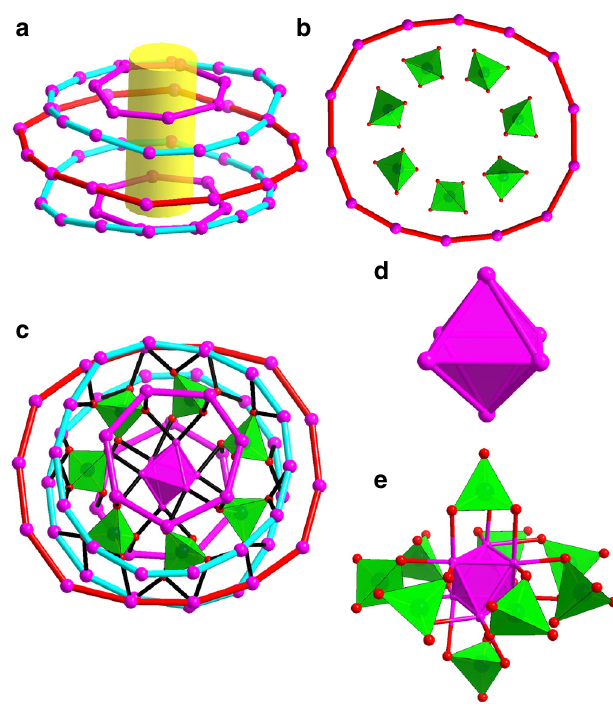
Fig. 3 Disassembled skeletal structure of SD/Ag7 . a Five concentric metallocycles: two Ag 7 (purple); two small Ag 14 (cyan) and one large Ag 14 (red). b Seven MoO 4 2 − anions arranged along the equatorial Ag 14 ring. c The bonding of MoO 4 2 − with Ag 14 rings and inner Ag 6 kernel with Ag – O bonding highlighted by black. d The polyhedral mode showing octahedral Ag 6 kernel. e The Ag 6 kernel protected by nine MoO 4 2 − anions with seven in the equator and two at the poles. (Colour legend: purple, Ag; red, O; green,